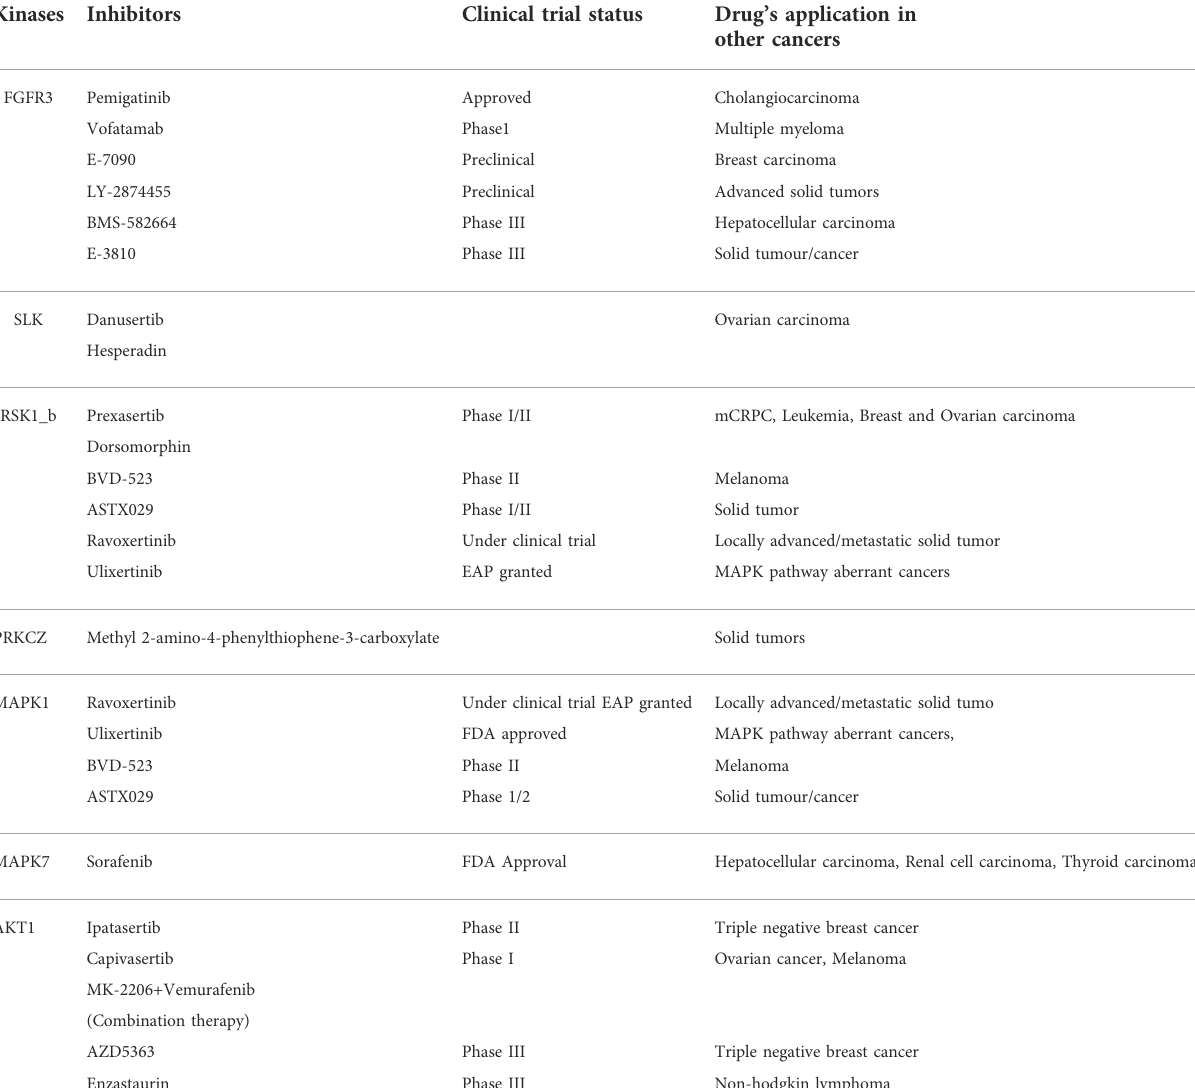
TABLE 1 Kinases and the clinical trial status of corresponding inhibitors along with current application in other cancers. Kinases